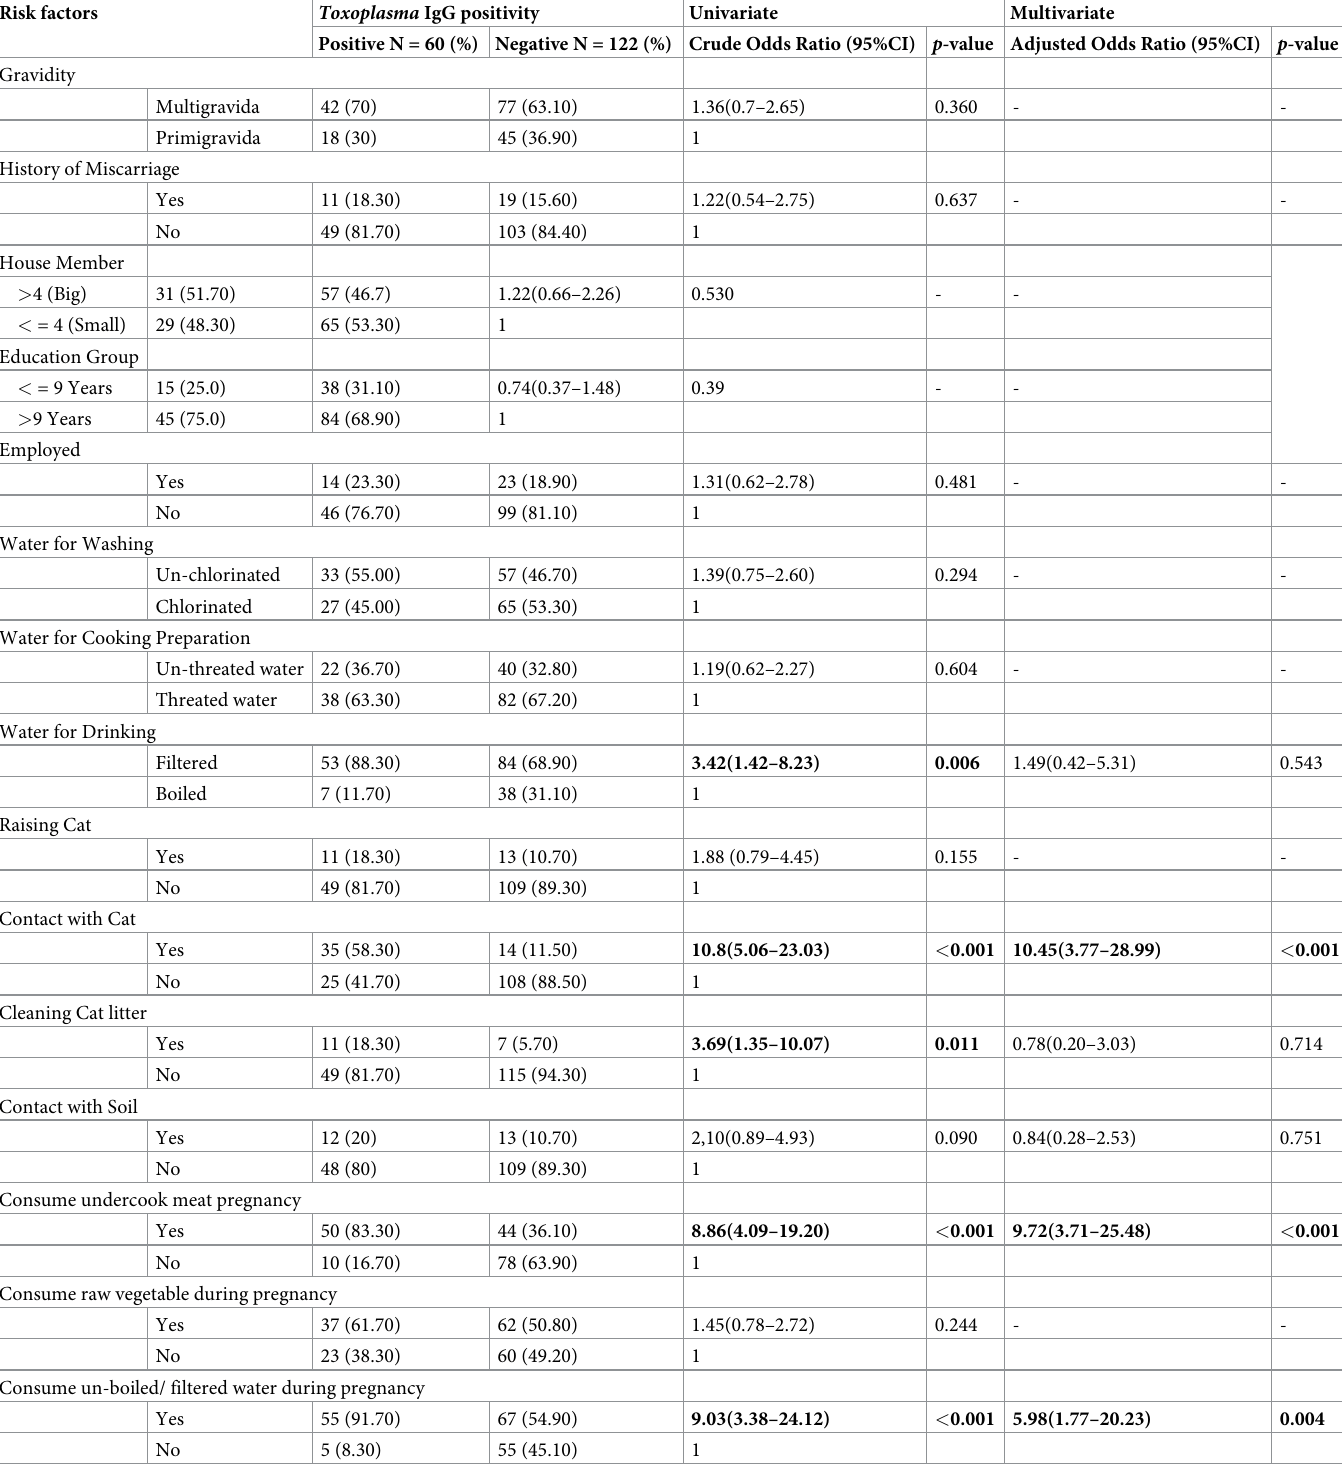
Table 3. Risk factors associated with Toxoplasma gondii IgG antibody positivity among pregnant mother attending primary health center in Makassar,